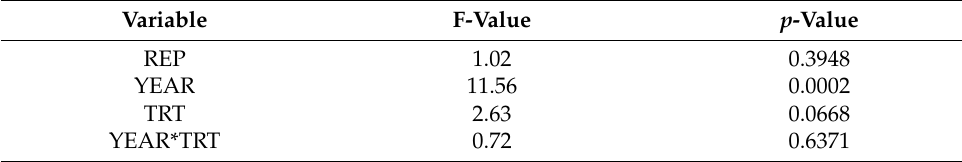
Table 9. Analysis of variance results for bush beans